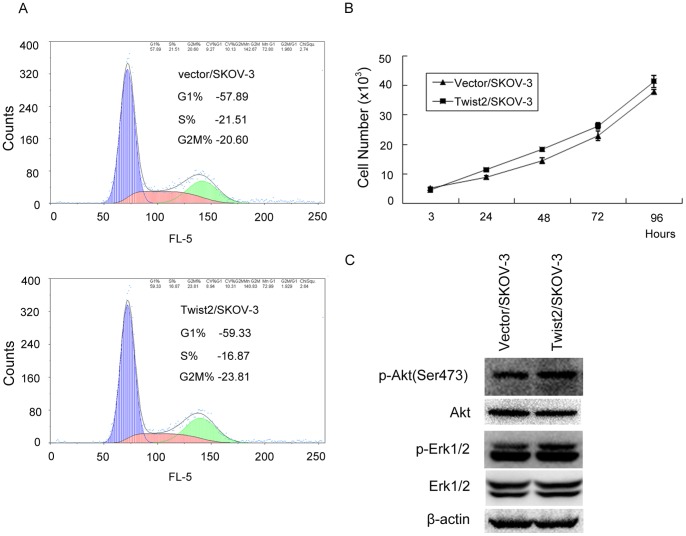
The proliferation influence of SKOV-3 cells by Twist2.
A. Flow cytometry analysis showed no difference of the cell cycle distribution between SKOV-3 cancer cells with or without Twist2 ectopic expression. B. The proliferation rate of the transfected cells was detected and compared with that of the vector control through viable cell counts using trypan-blue staining. Triplicate assays were performed in each group of cells. Data were expressed as mean ± SD. No obvious influence of Twist2 was observed on cell growth rate. C. Expressions of Akt, Erk1/2, and their phosphoralation forms indicated Twist2 had no effects on proliferation by Western blot. Compared with Vector/SKOV-3 cells, no obvious changes of Akt, Erk1/2, and their phosphorylation forms were found in Twist2/SKOV-3 cells.